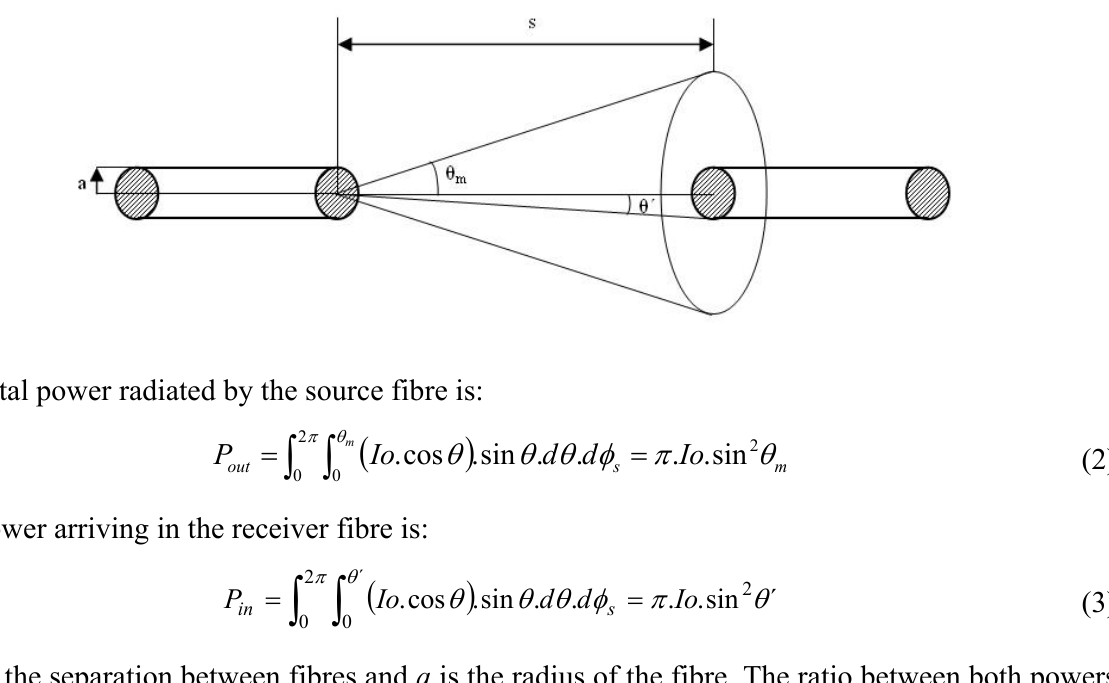
Figure 1 . LED emits light through the